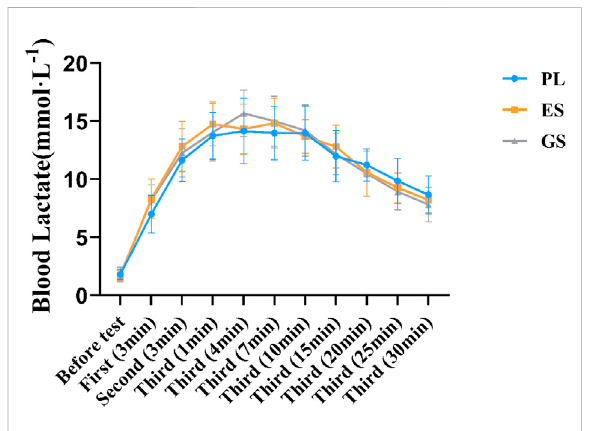
FIGURE 4 Blood lactate responses during the experiments. Values are means±SD.First(nmin):nminutesafterthe fi rstWACT;Second(n min): n minutes after the second WACT; Third (n min): n minutes after the third